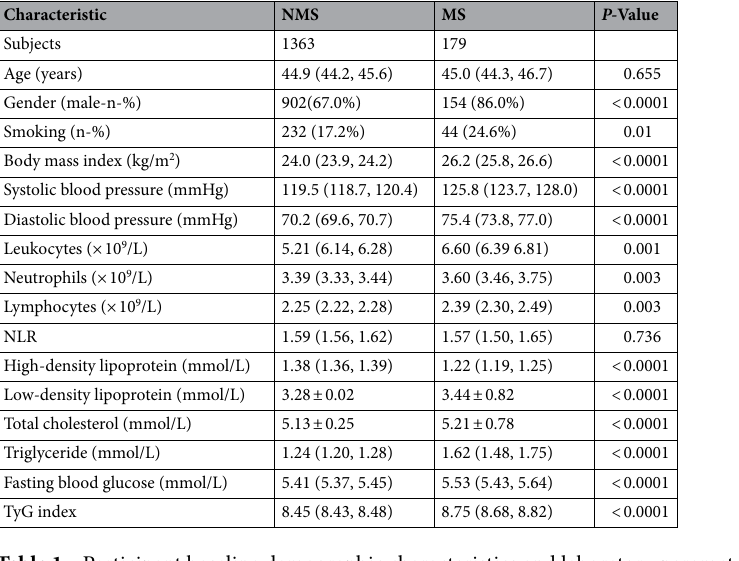
Table 1. Participant baseline demographic characteristics and laboratory parameters by metabolic syndrome status (n =